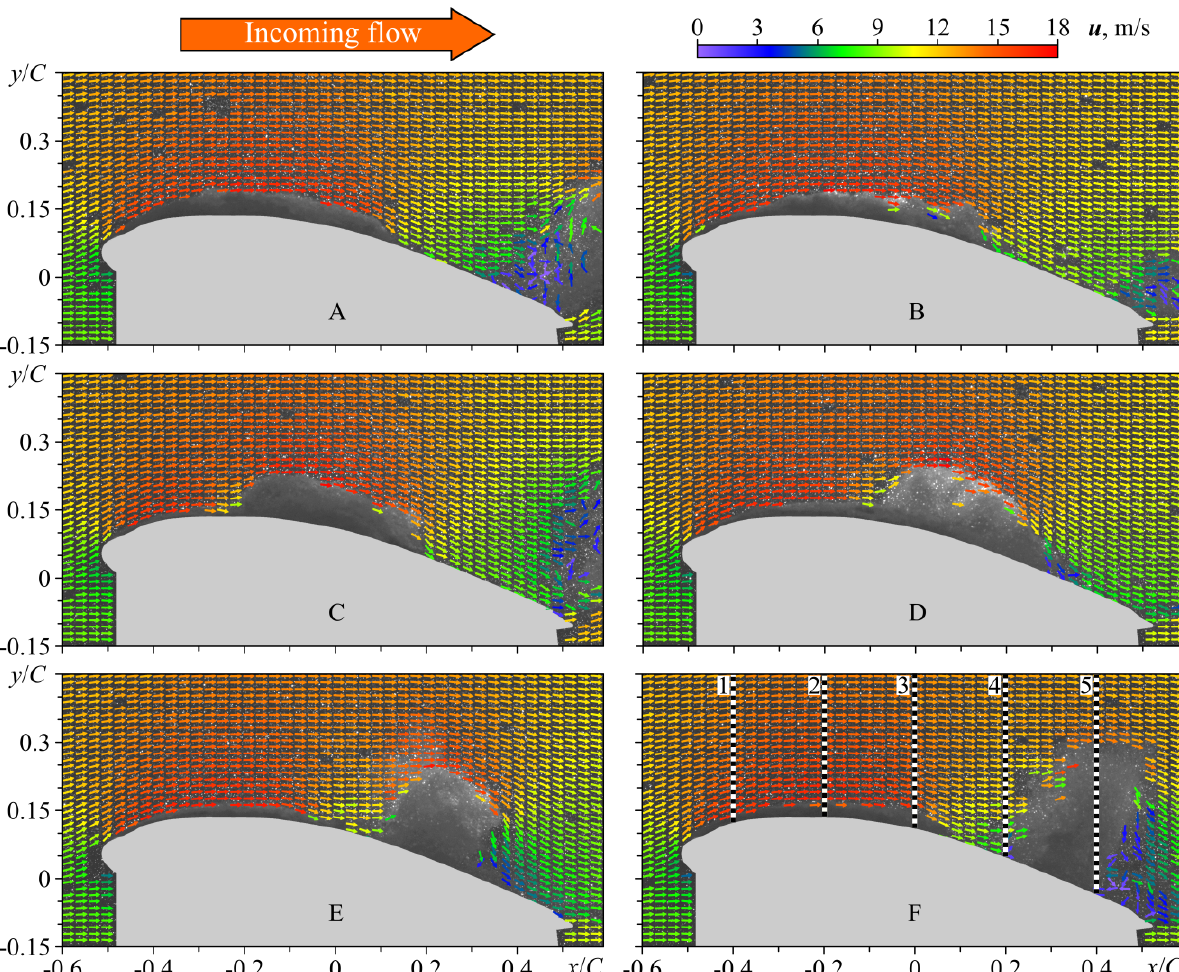
Figure 2. Instantaneous velocity vector fields around hydrofoil at different phases of oscillation period ( A – F ) for unsteady cloud cavitation conditions (regime I). Every sixth and every third vector is shown in vertical and horizontal direction, respectively. Gray mask covers the image area occupied by hydrofoil and its shadow below. Dashed black-white vertical lines in image F denote cross-sections in which profiles of various turbulence quantities are presented